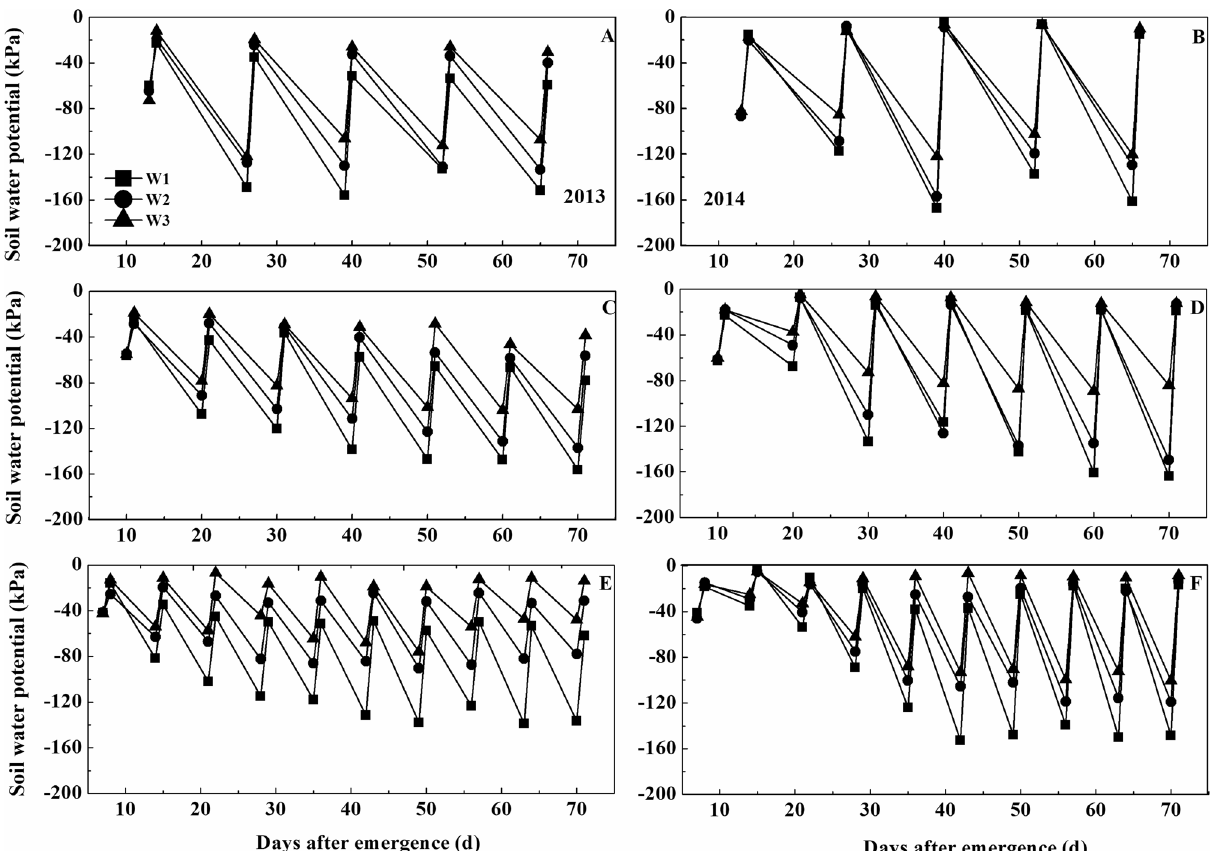
Figure 2. Temporal changes in soil water potential in the 0–20 cm depth under ‘Xinchun 6’. ( A ) Soil water potential under D1 treatment in 2013. ( B ) Soil water potential under D1 treatment in 2014. ( C ) Soil water potential under D2 treatment in 2013. ( D ) Soil water potential under D2 treatment in 2014. ( E ) Soil water potential under D3 treatment in 2013. ( F ) Soil water potential under D3 treatment in